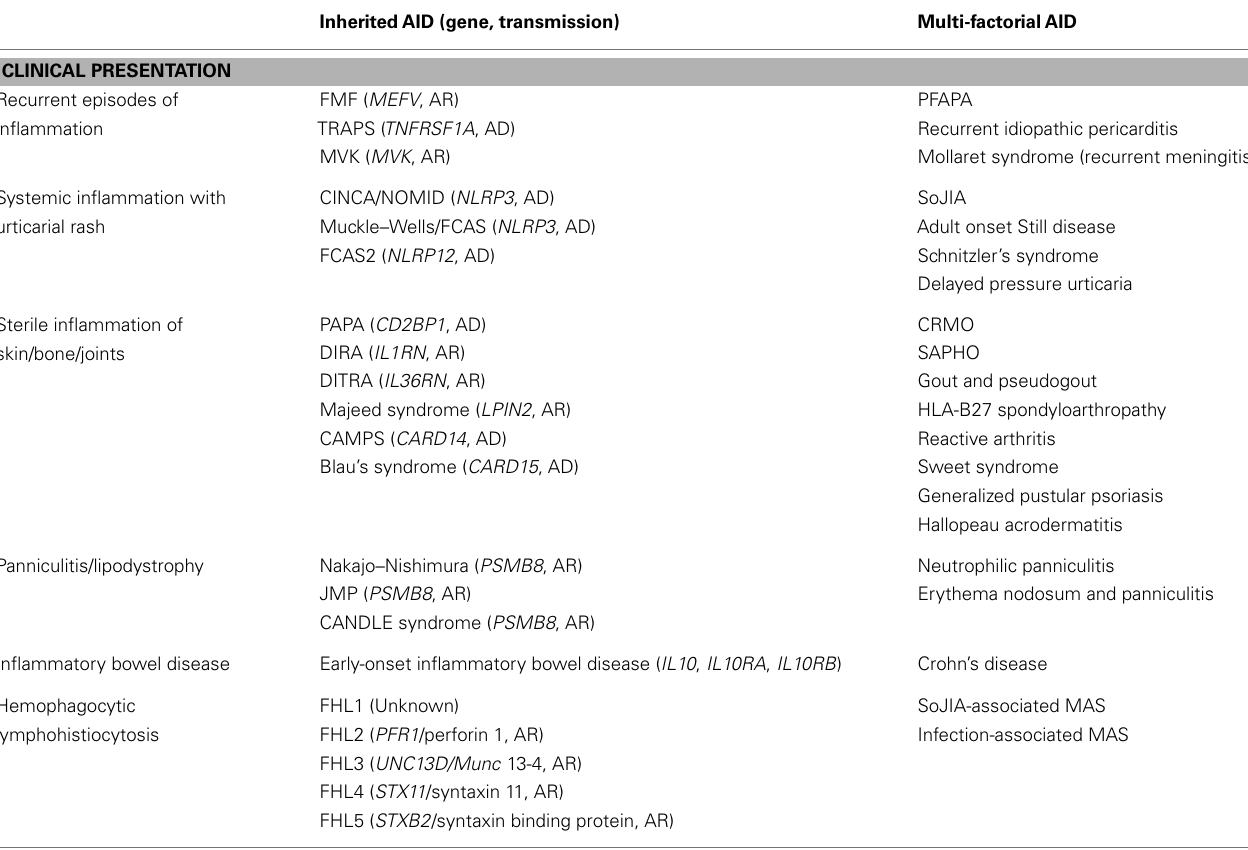
Table 1 | Clinical classification of inherited and multi-factorial autoinflammatory diseases (AID) . InheritedAID (gene, transmission)